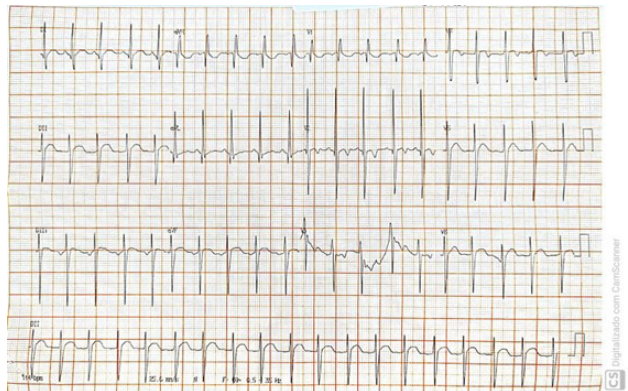
Fig. 2 - Electrocardiogram showing ectopic atrial rhythm with right ventricular overload and divisional block of the left anterosuperior branch.